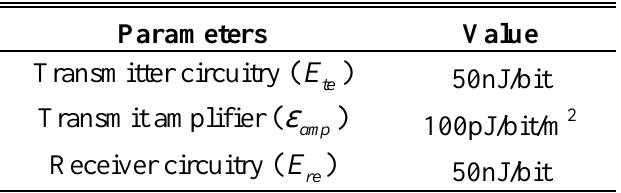
Table 2 . Radio energy consumption of a sensor